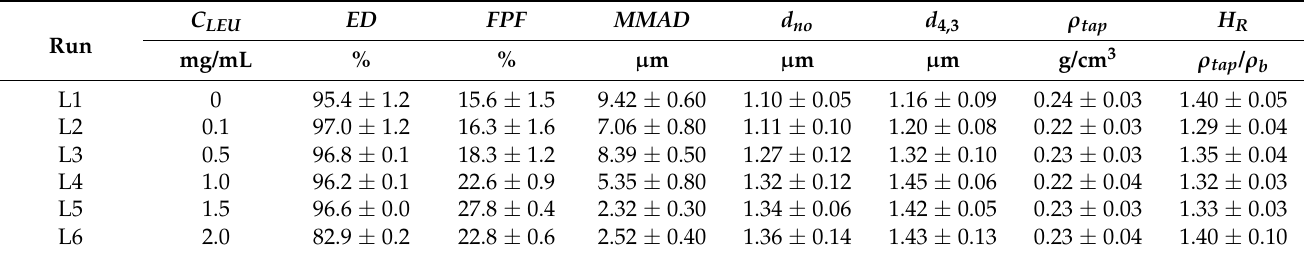
Table 2. In vitro aerosolization experiment results of HP- β -CD carrier particles with the addition of